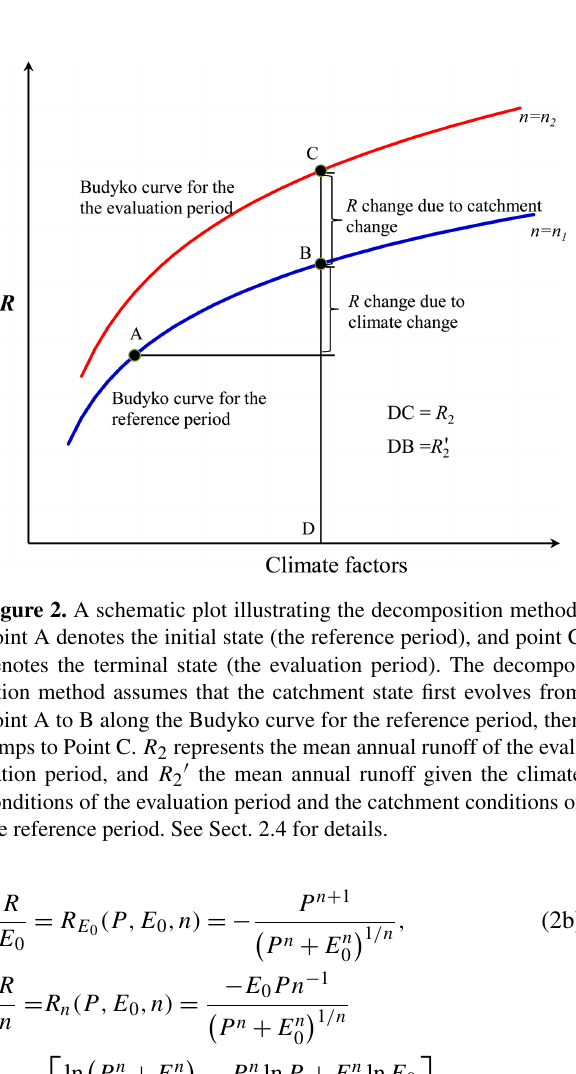
Figure 1. For a nonlinear function z = f (x) , the total-differential method (a) and the complementary method (b) do not accurately estimate the effect ( (cid:49)z x ) of x on z when x changes by (cid:49)x , but the LI method (c) does. For a univariate function, the z change is exclusively driven by x , so that (cid:49)z x should be equal to (cid:49)z . (cid:49)z x = (cid:49)z in (c) but not in (a) and (b) . λ x in (c) represents the average sensitivity along the curve AC and λ x = (cid:49)z/(cid:49)x ; see Appendix E for details.